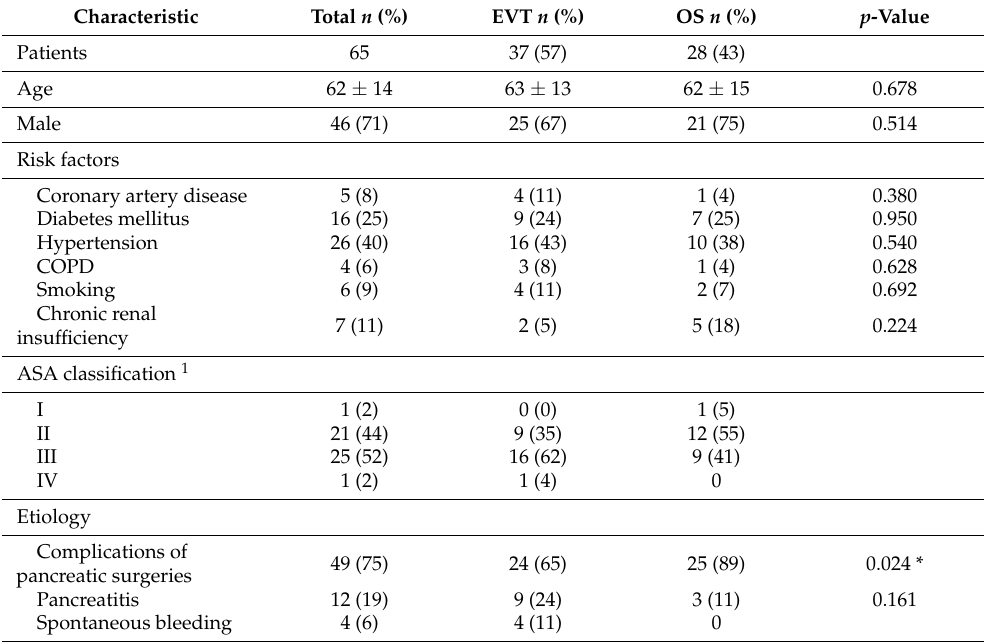
Table 1. Descriptive characteristics and